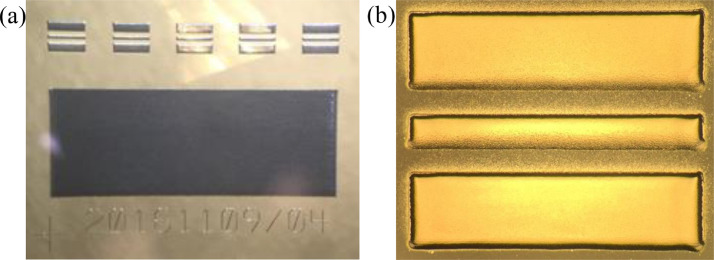
An optical micrograph of a complete sample (on glass) is shown in (a). The complete sample comprises five co-planar waveguides and a single 8 mm x 3 mm pad for 4-point probe conductivity measurements. An optical micrograph of an individual co-planar waveguide (on silicon) is shown in (b). The waveguides are 1 mm wide, have a 100 µm wide center conductor, and gap widths of 100 µm.